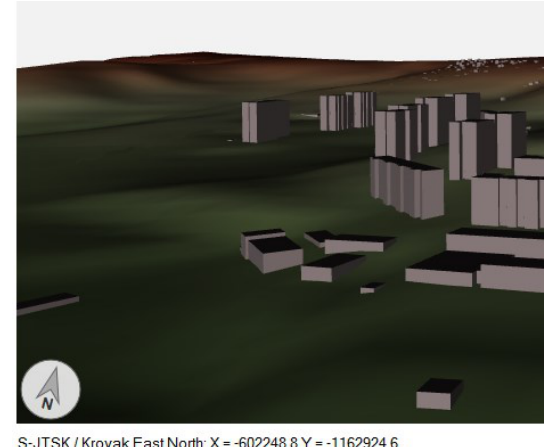
Figure 6. North arrow and coordinates of the virtual